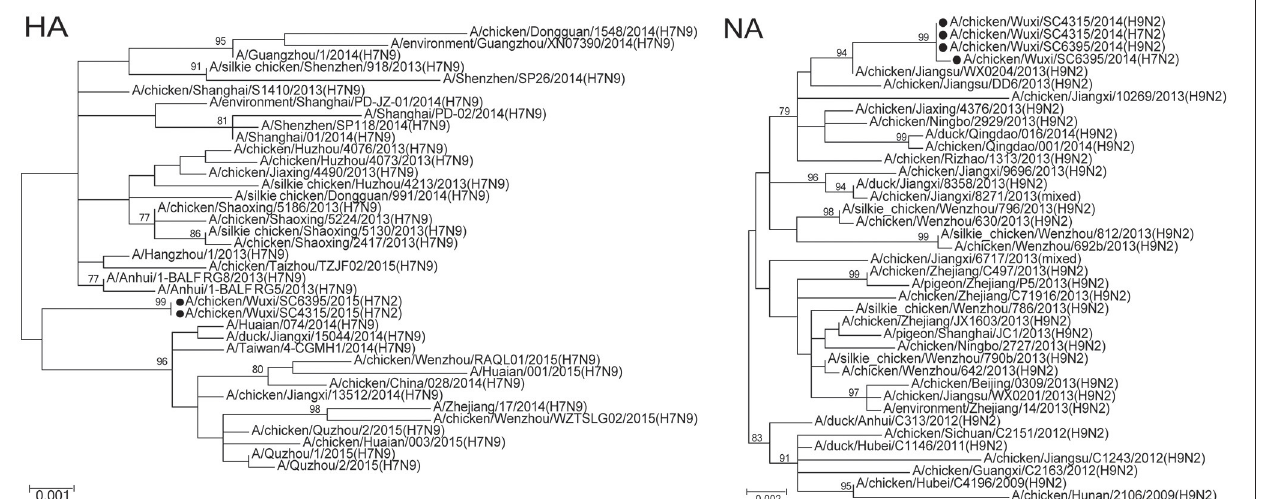
pathogenic effects in poultry. Substitution at A138, A160, V186, and L226 (H3 numbering) was observed suggesting a possible increased affinity for binding human α 2, 6-linked sialic acid receptors. Three amino acid deletions (63–65) were observed in